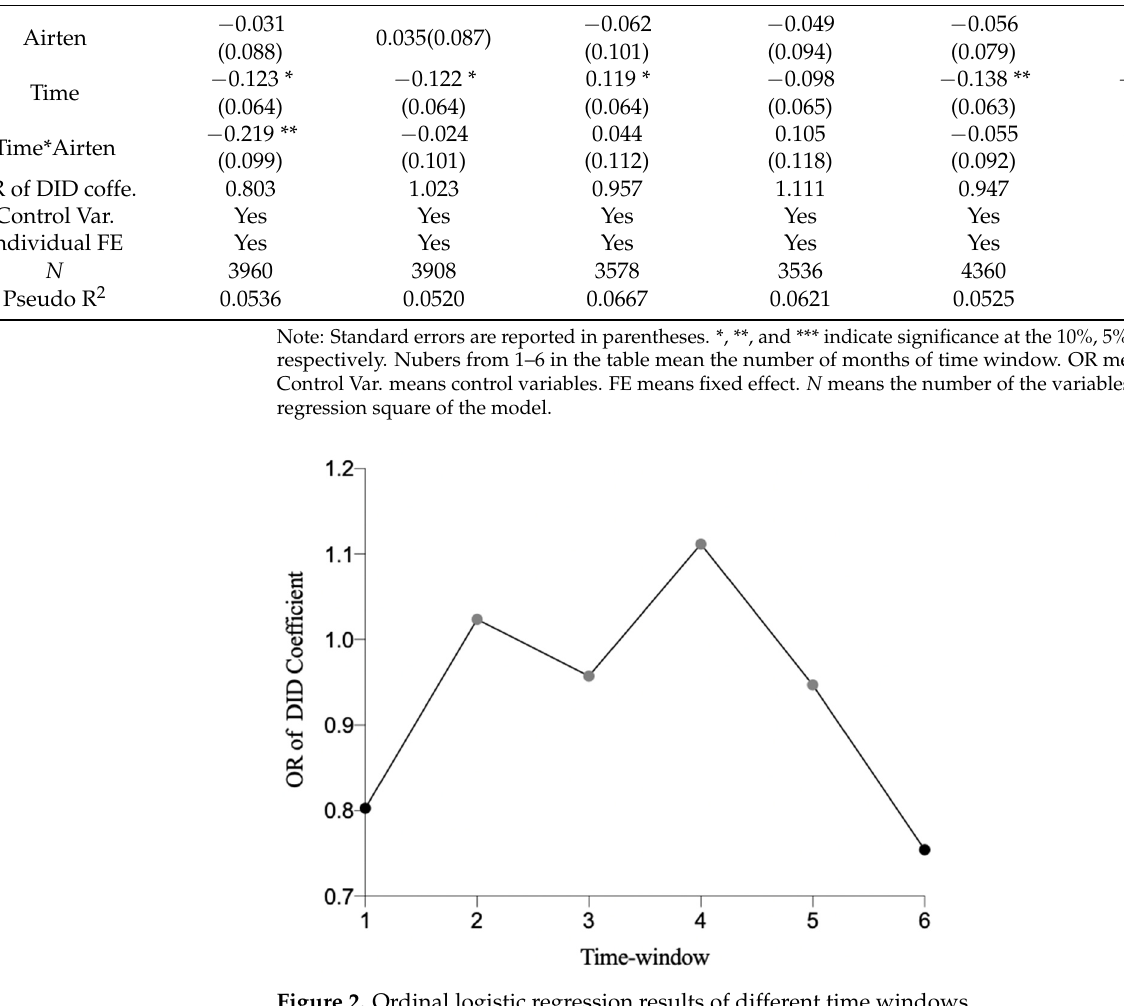
Figure 2. Ordinal logistic regression results of different time windows.